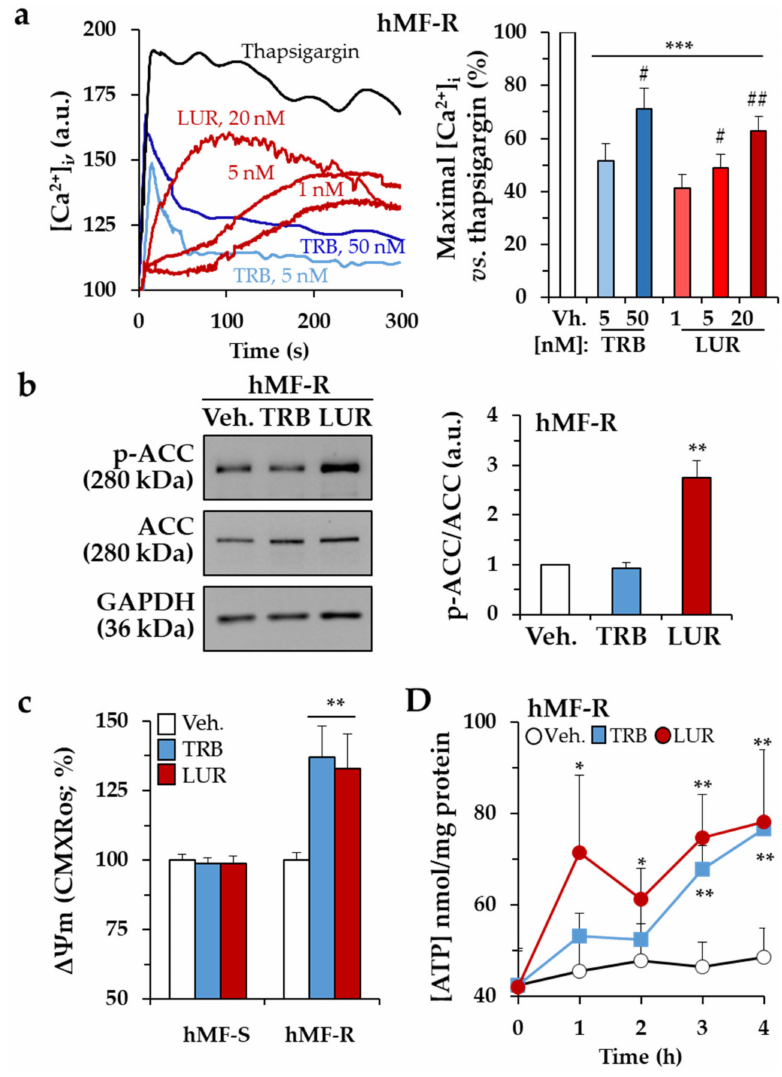
Figure 3. Time-lapse e ff ects of TRB and LUR in hMF intracellular Ca + 2 signaling and mitochondrial membrane potential. ( a ) Intracellular Ca + 2 concentration in hMF-R after thapsigargin (200 nM), TRB, or LUR treatment; ( b ) p-ACC / ACC ratio after 30 min of treatment with TRB (50 nM) and LUR (20 nM); ( c ) hMF-R and hMF-S mitochondrial membrane potential after 24 h of treatment with TRB (5 nM) and LUR (1 nM); ( d ) intracellular ATP levels in hMF treated with TRB (5 nM) and LUR (1 nM). Results show a representative blot out of three ( b ) and the means + S.E.M. from 8 di ff erent donors, * p < 0.05; ** p < 0.01; *** p < 0.001 vs. the vehicle condition; # p < 0.05; ## p < 0.01; vs. the corresponding condition with TRB (5 nM) or LUR (1 nM), respectively. a.u., arbitrary